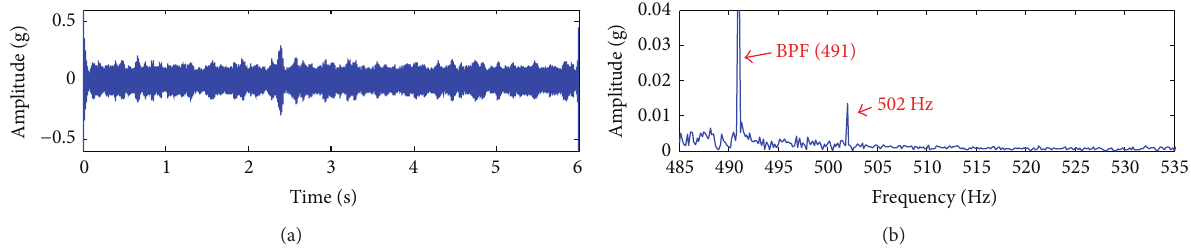
Figure 15: Output signals of the ASR method under 16mm crack condition: (a) time-domain waveform and (b) frequency spectrum.